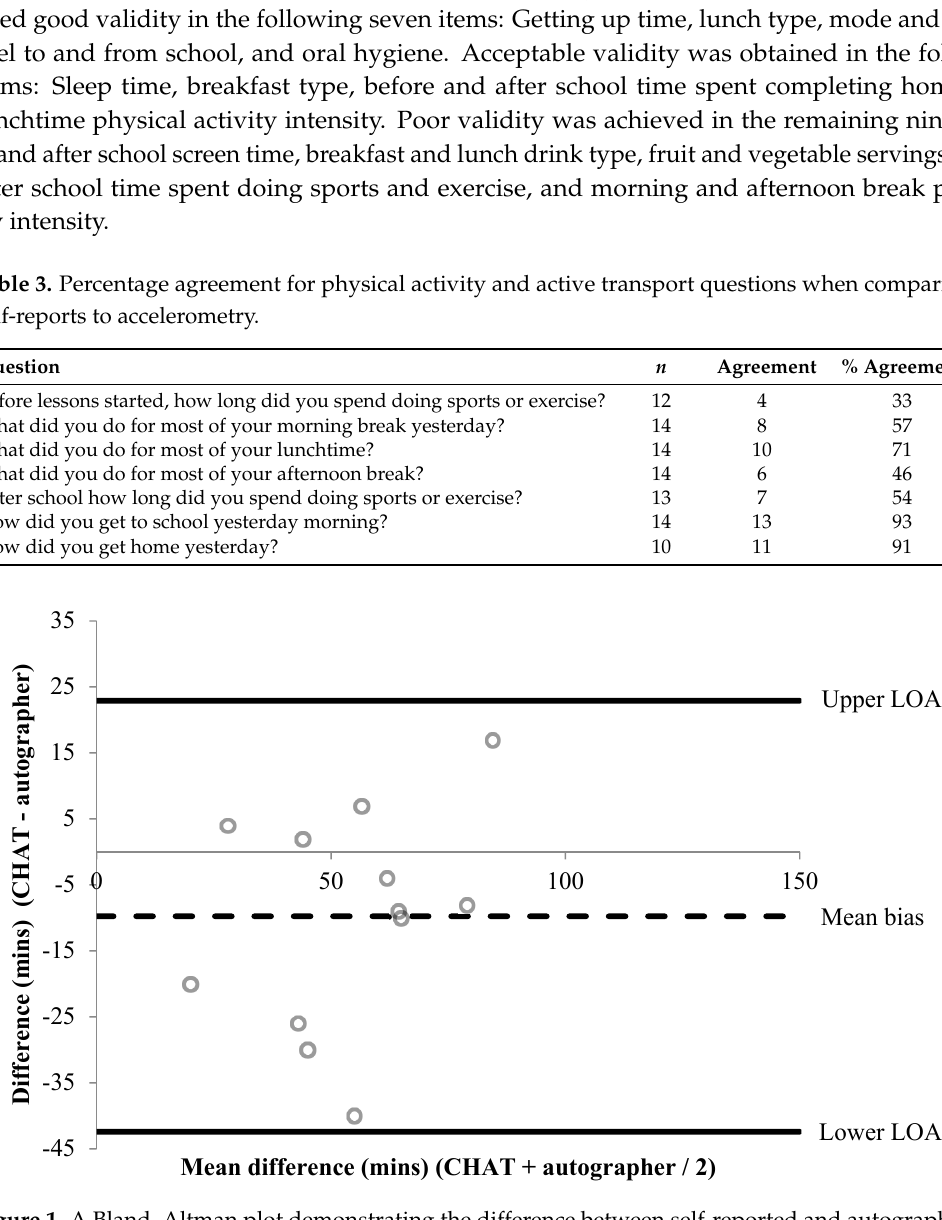
Table 2. Percentage agreement for between-measure agreement of self-reports compared to the autographer for all 21 items.